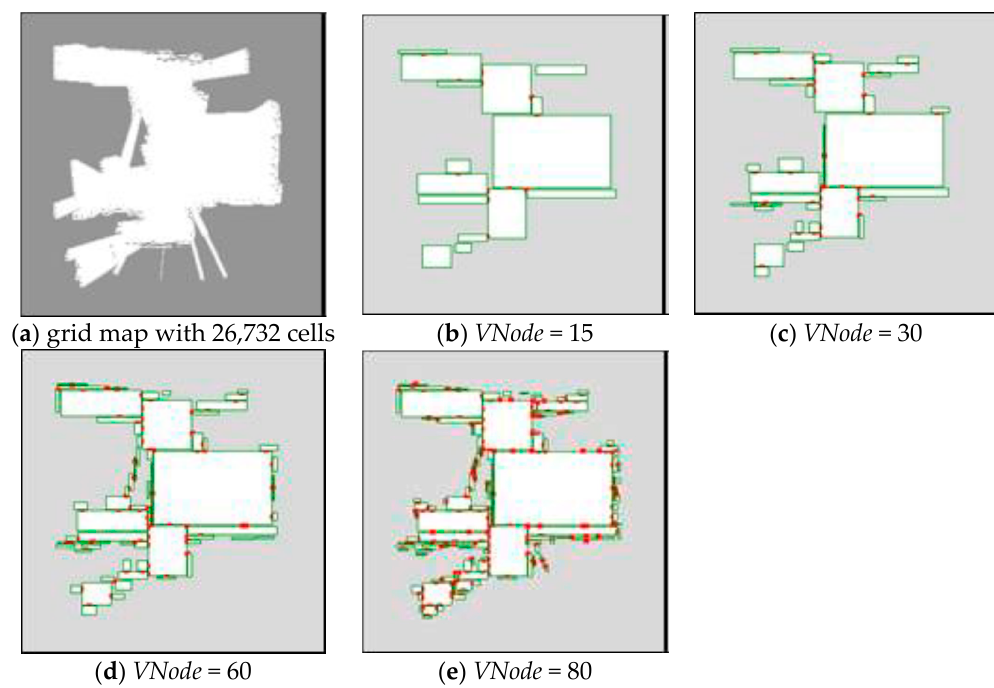
Figure 10. The coverage process using Rmap scheme in Figure 8c. ( a ) is the grid map of the coverage area; ( b – e ) shows the process of Rmap generated by increasing the number of nodes.